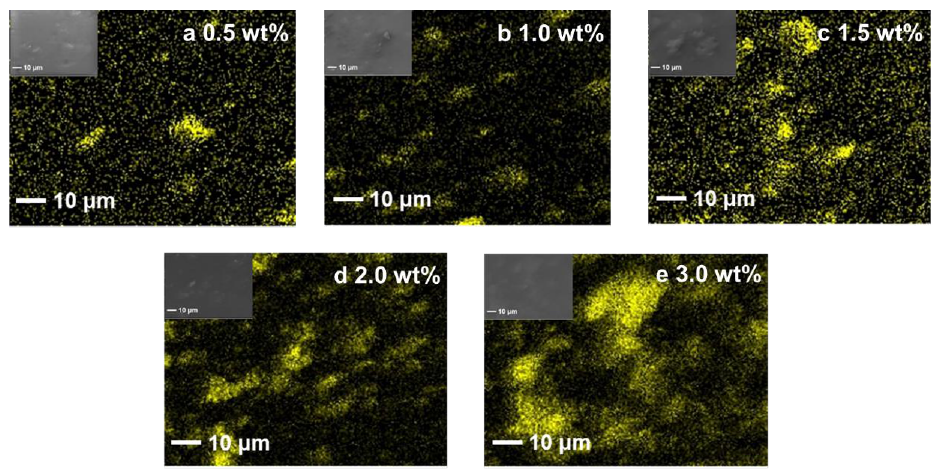
Figure 6. Energy-dispersive spectroscopy (EDS) of Ti element distribution for the SSC/Ti 3 C 2 T x composite membranes.